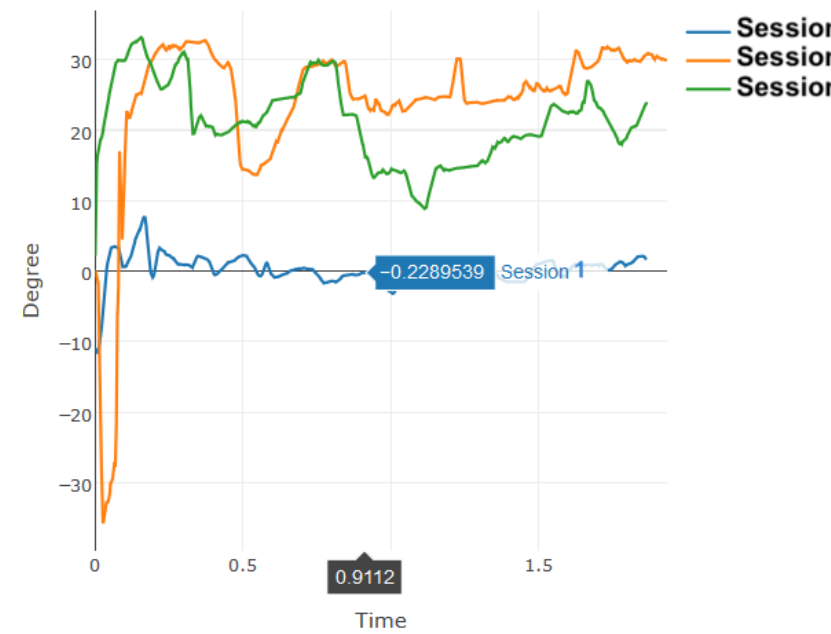
Figure 12. One patient’s Kinematic analysis over time of a lateral flexion exercise in different